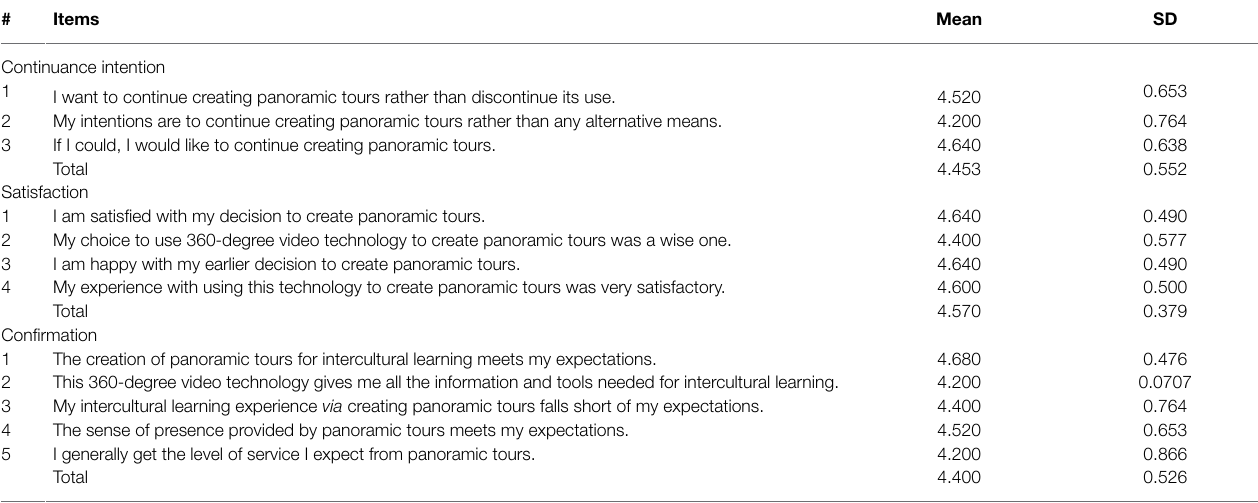
TABLE 7 | Perceive learning experience to create panoramic tours using technology.